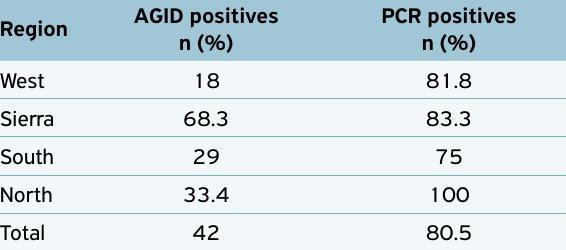
Table 1. Relationship between collecting regions, performed analysis and